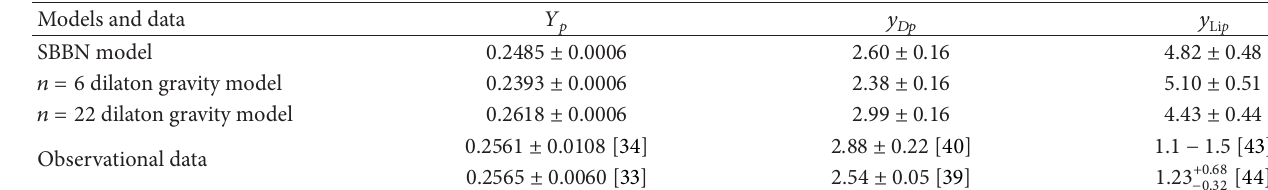
Table 1: The abundances of He-4, deuterium, and Li-7 for different